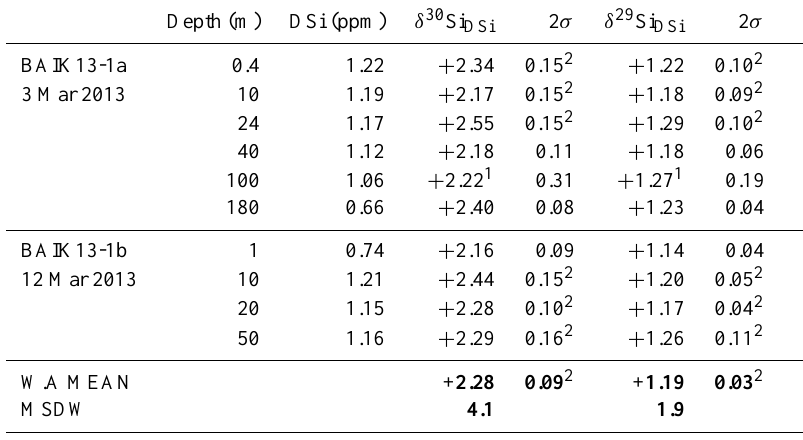
Table 1. δ 30 Si DSi , respective uncertainties (2 σ , unless otherwise stated) and DSi concentrations for sampling in South Basin of Lake Baikal at site BAIK13-1 in March 2013. Bold values correspond to the weighted average mean values (with respective errors) of data presented. Data are plotted in Fig. 3.